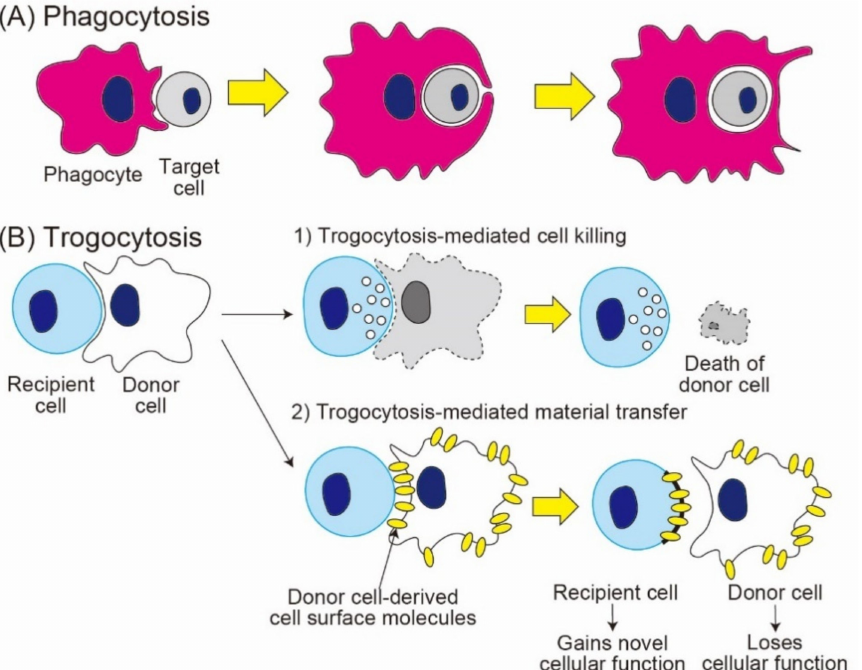
Figure 1. Characteristics of phagocytosis vs. trogocytosis. ( A ) In the process of phagocytosis, phagocytes swallow the whole cell body of target cells; ( B ) in the process of trogocytosis, recipi- ent cells nibble the cell body of donor cells. Trogocytosis results in either (1) the death of target cells (trogocytosis-mediated cell death) or (2) the transfer of cell surface molecules, together with membrane patches, from donor cells to recipient cells (trogocytosis-mediated material